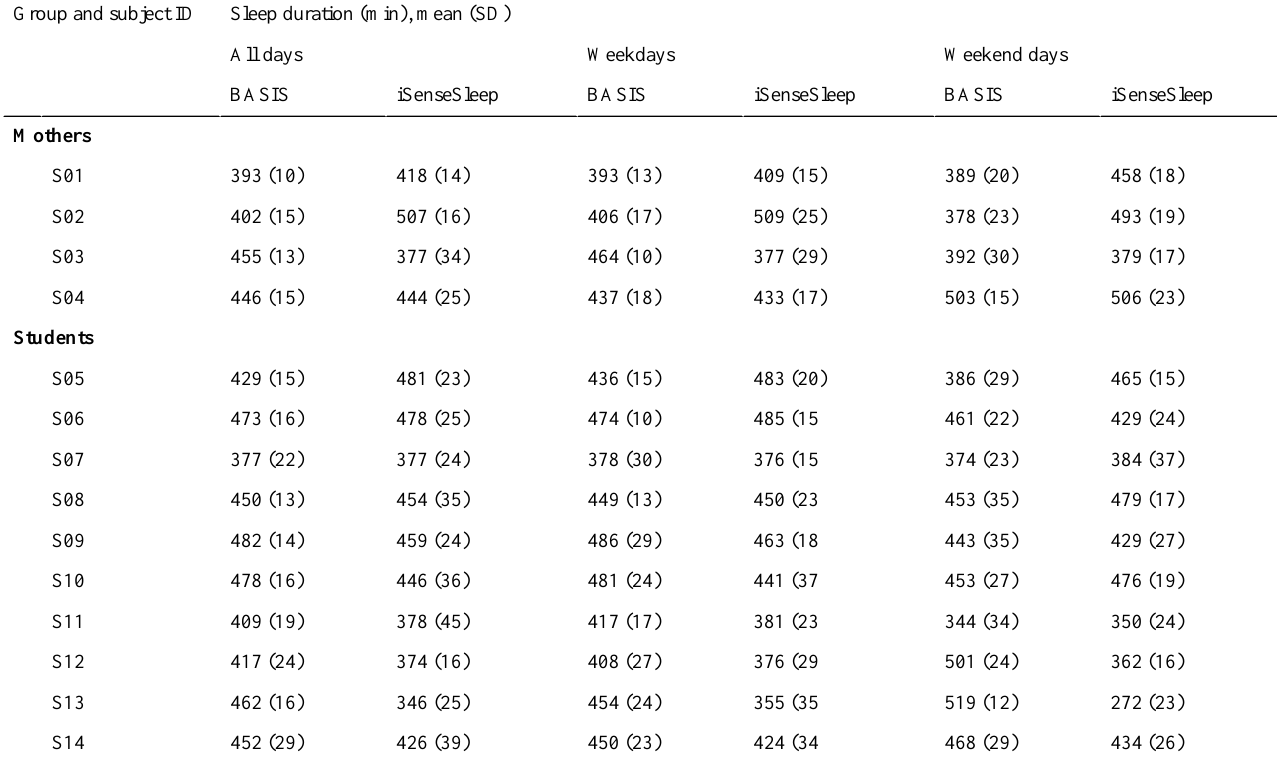
Table 2. Average sleep duration comparing the BASIS smartwatch and the iSenseSleep algorithm. Sleep duration (min), mean (SD)Group and subject ID